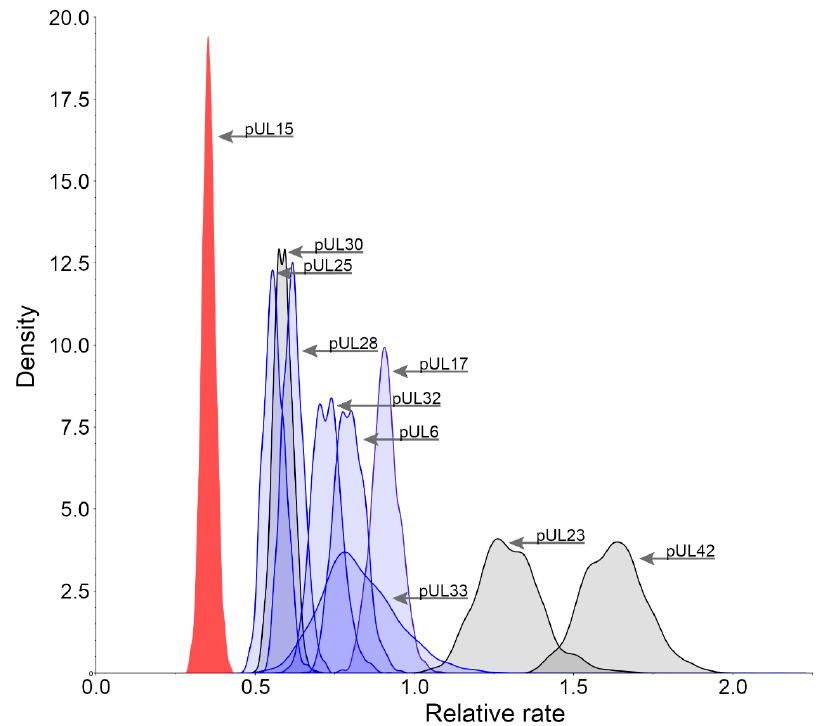
Figure 2. Posterior distributions of relative substitution rates. Protein products of HHV-1 involved in the packaging of DNA (pUL6, pUL15, pUL17, pUL25, pUL28, pUL32, and pUL33) are shown in blue and the protein products of HHV-1 that are currently used as antiviral targets (pUL23, pUL30 and pUL42) are shown in gray. pUL15 (red) has been highlighted to show an extremely conservative rate of change relative to the other packaging related genes.